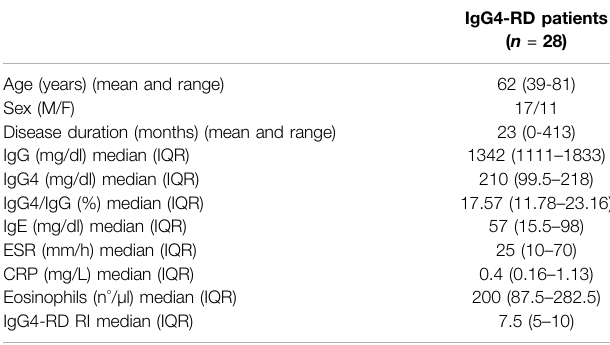
TABLE 1 | Demographic and serological characteristics of IgG4-RD